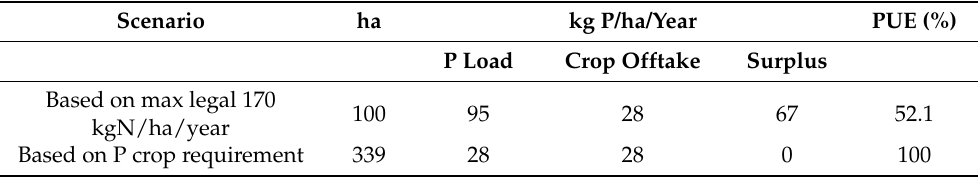
Table 2. P-loading scenarios for the application of broiler manure (9500 kg P/year) to different areas of cropland, based on N and P crop requirements for a farm producing 50,000 birds per year. PUE was calculated using Formula (2). Base unit data for feed, production, and manure derived from [72]. Scenario ha kg P/ha/Year PUE (%)